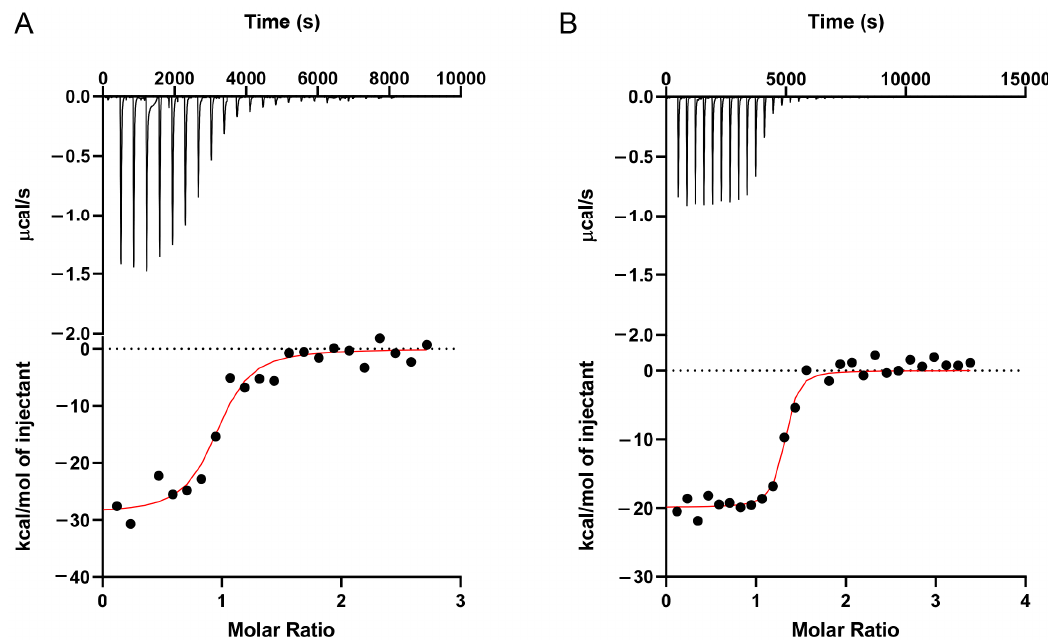
Figure 5. ITC traces of 150 μ M OTC titrated into 9 μ M OTC5 at ( A ) pH 6.0 and ( B ) pH 8.3. Both samples contained 2 mM Mg 2+ . Table 1. Thermodynamic values of the aptamers based on ITC a. . Aptamer